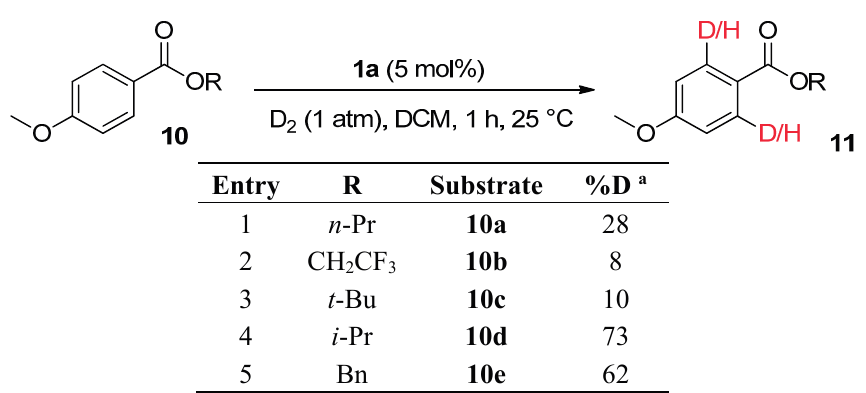
Table 2. Labelling of electron-rich benzoate esters using catalyst 1a